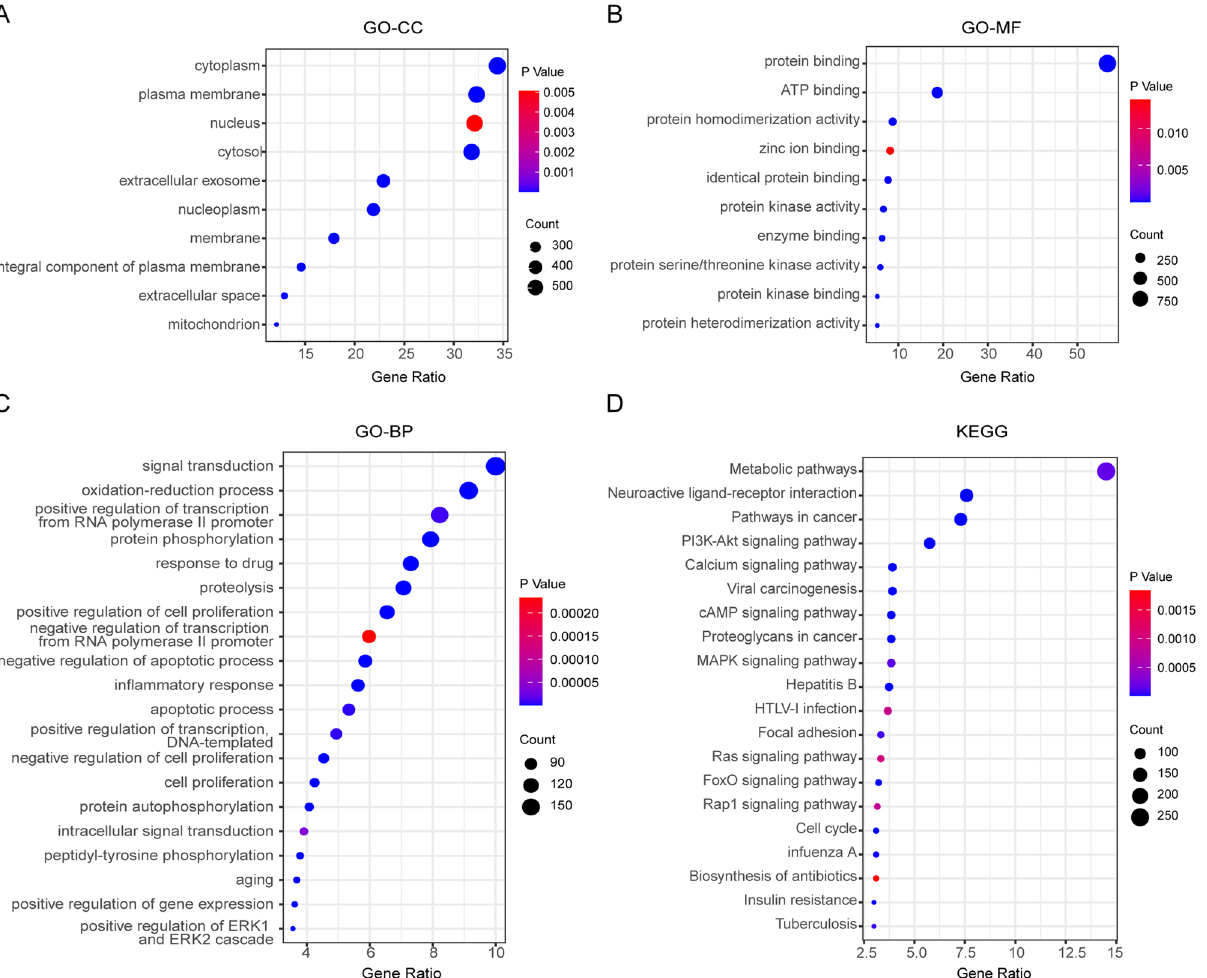
Figure 2. Functional enrichment of TGYP target genes. Functional annotation of active compounds related to putative targets. ( A ) Enriched cellular components. ( B ) Enriched molecular functions. ( C ) Enriched biological processes. ( D ) Enriched KEGG pathways. [Fig. 2 was drawn by Sangerbox tools (http:// sange rbox. com/ AllTo ols? tool_ id= 96979